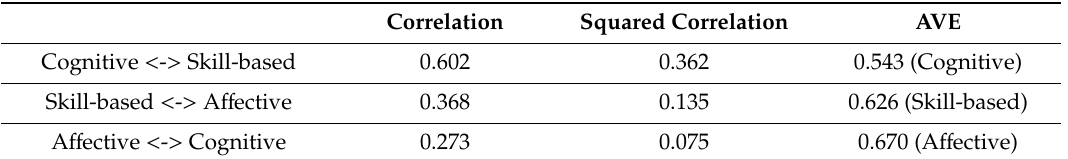
Table 4. The discriminant validity